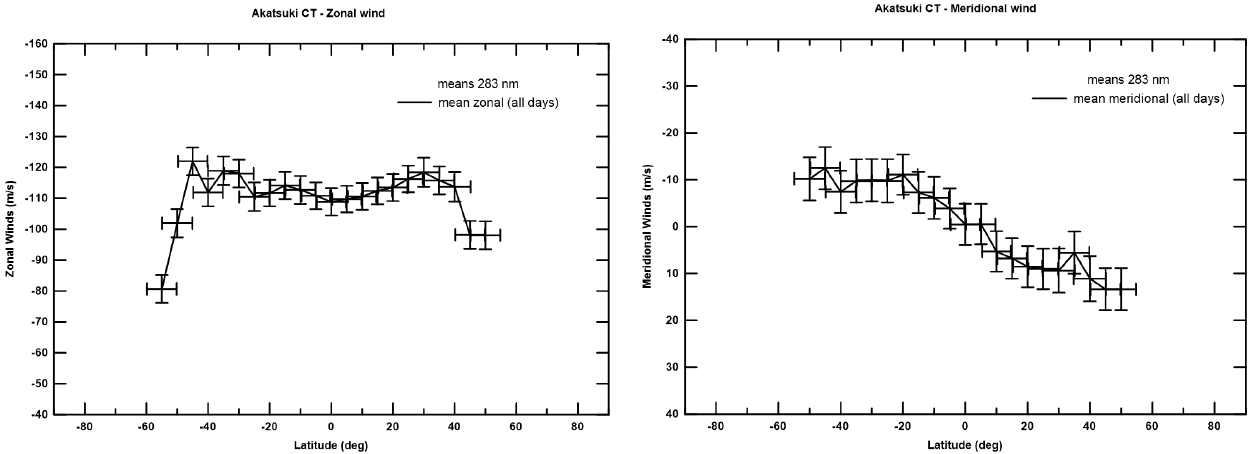
Figure 4. Left panel: Mean zonal wind latitudinal profile of the Akatsuki/UVI 283 nm filter results. Right panel: Mean meridional wind latitudinal profile also based on the same instrument and filter observations. Both mean profiles consist of the outcome of the weighted average performed upon the daily profiles shown previously from 26–31 January 2017. Each wind velocity magnitude presented is the result of the mean of each latitude band for all days with a binning of 5 ◦ in